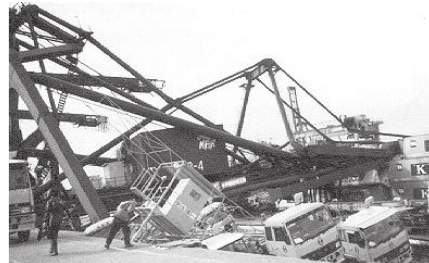
Figure 1: Collapsed crane at the Kobe Earthquake [21].